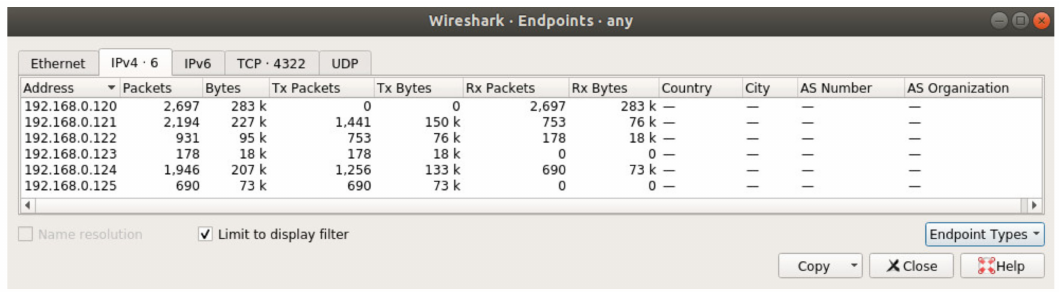
Figure 11. Statistics for non-optimized simulation.